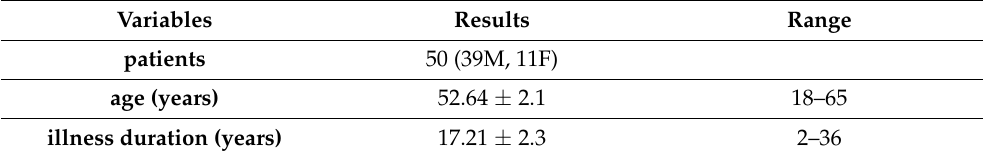
Table 1. Clinical characteristics of patients with psoriasis.